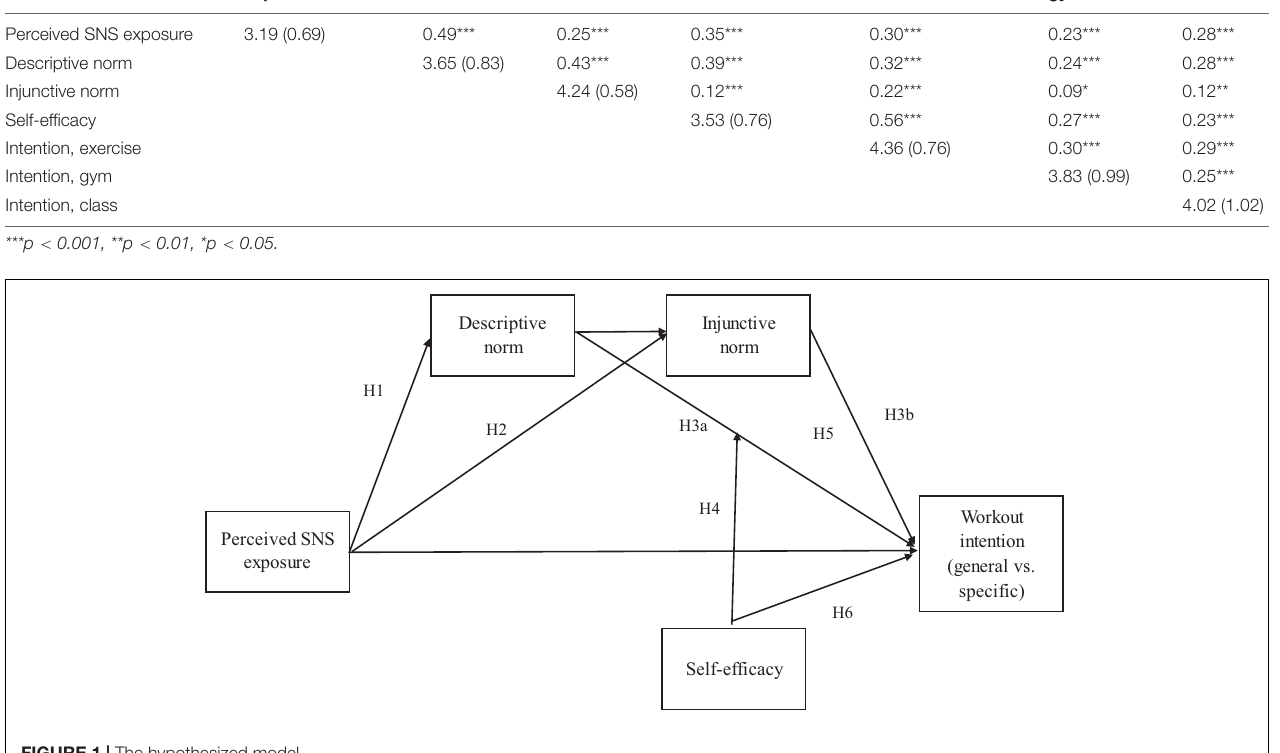
FIGURE 1 | The hypothesized model.